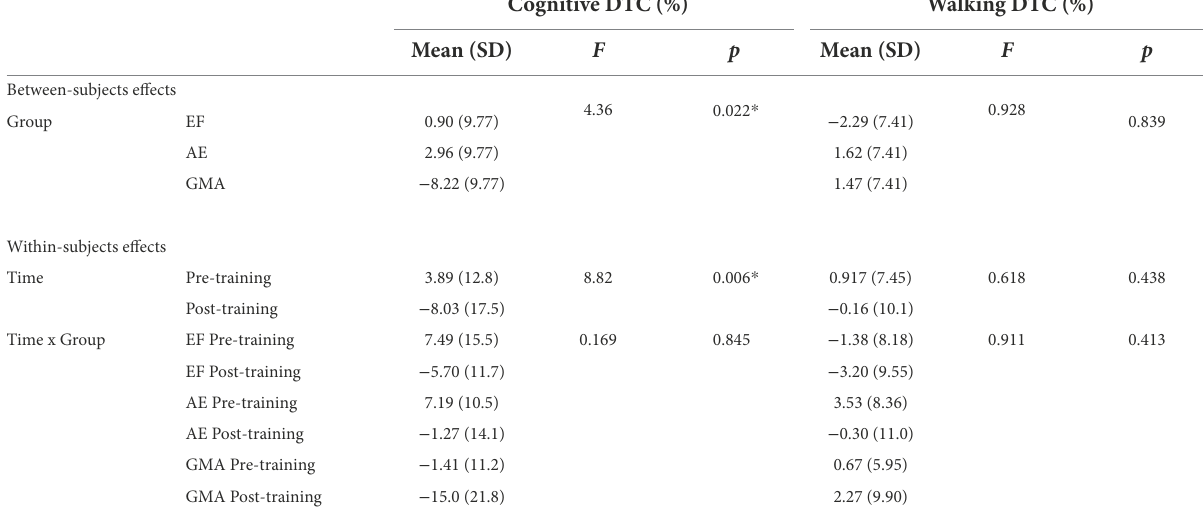
TABLE 1 Dual-task costs before and after training across groups.